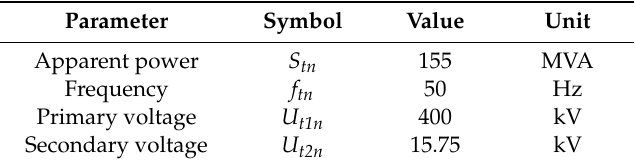
Table A3. Transformer nominal data.